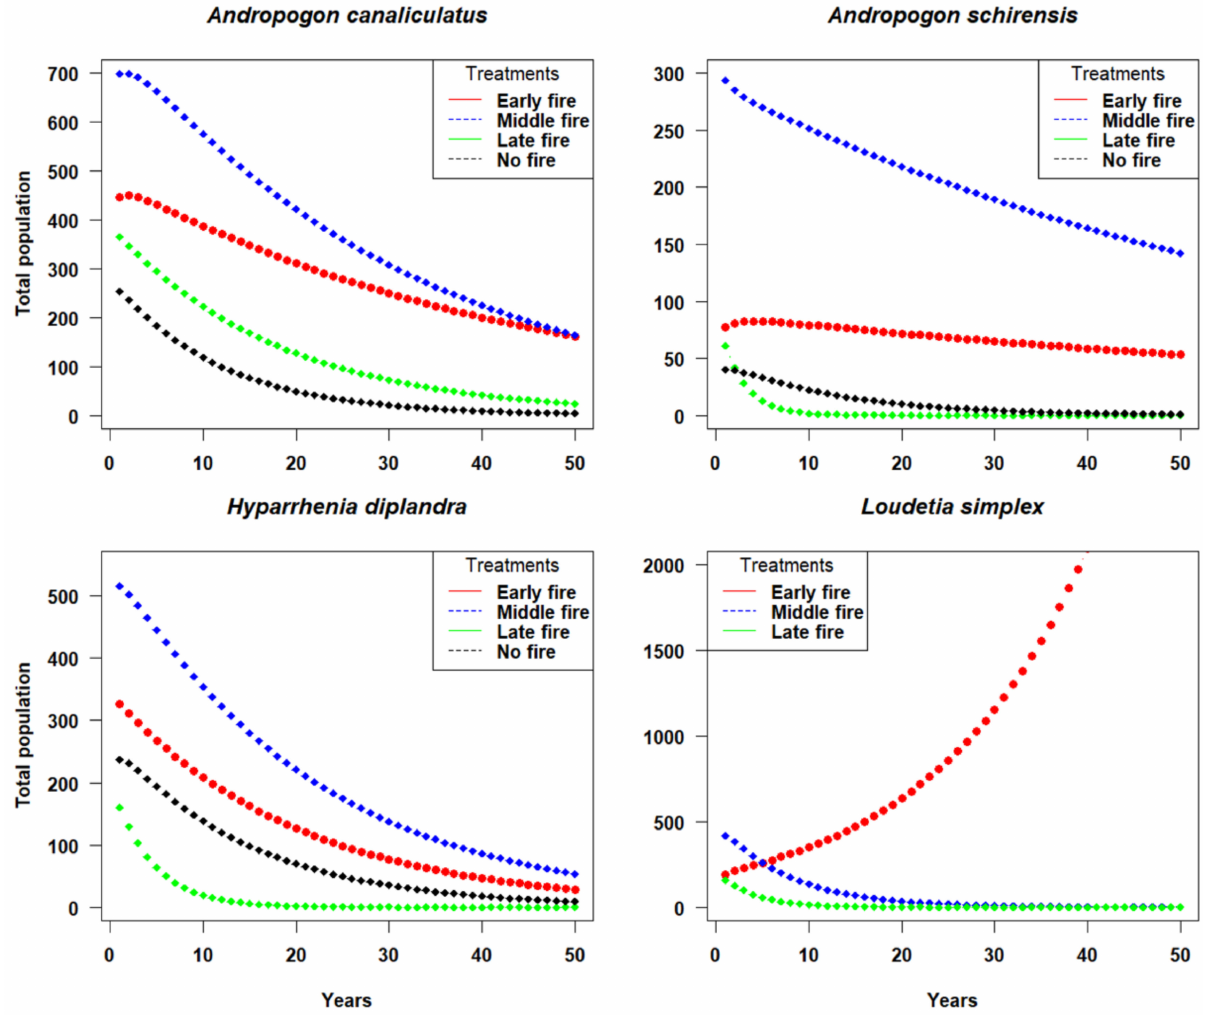
Figure 1. Total population size projected over 50 years by species and fire treatment using the average transition